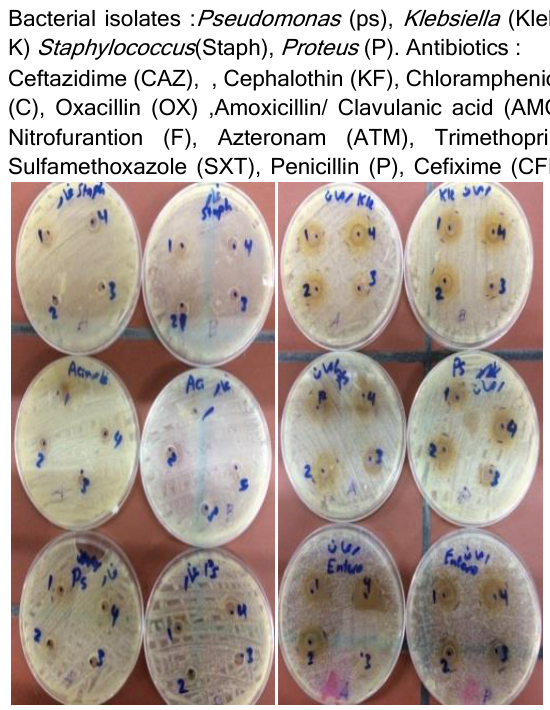
Figure (2) Antibacterial activity of Pomegranate extracts (left)and Bay leaves extracts (right)